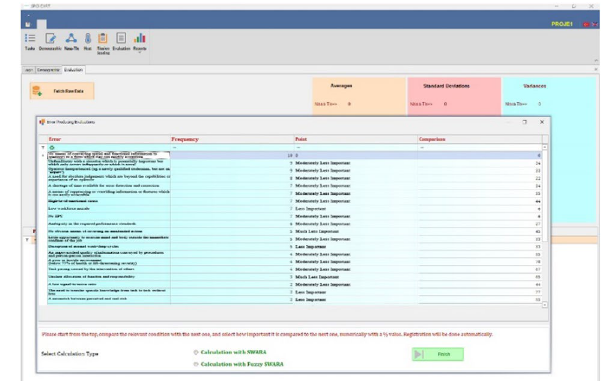
Fig. 5 NTM-DSS user interface